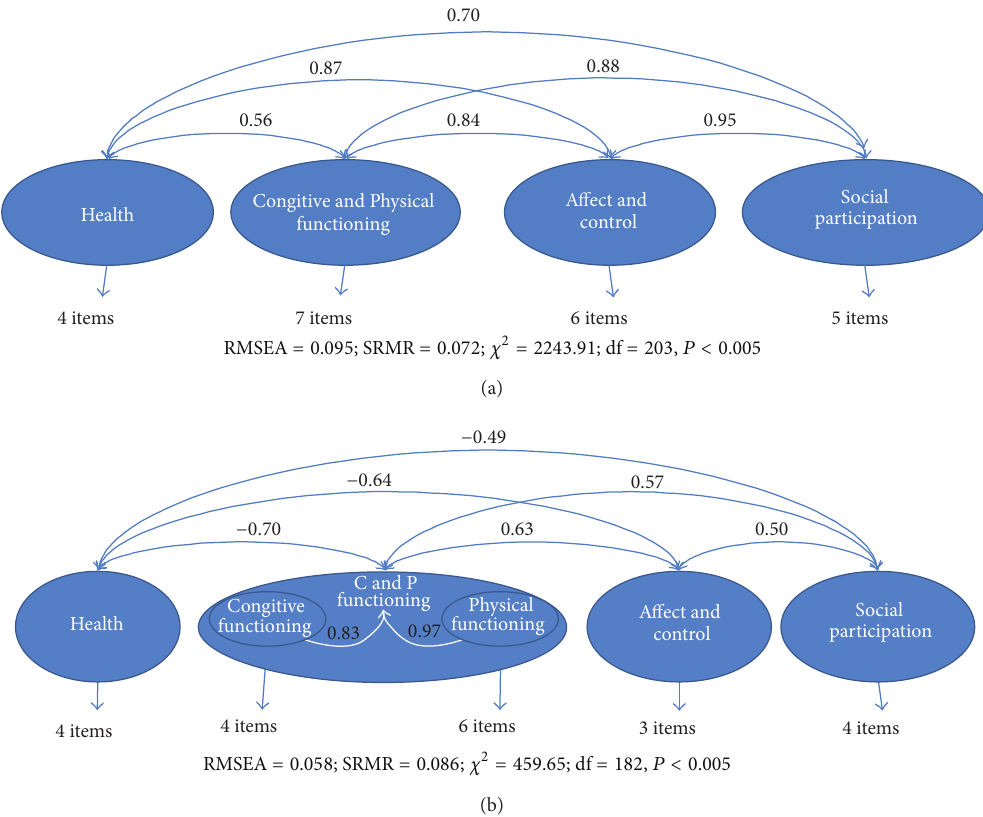
F 1: Structural Equations Modeling of four-domains model of ageing well: (a) from lay conceptalizations ( N = 1,189), and (b) from ELEA PROJECT multimethod data base ( N =